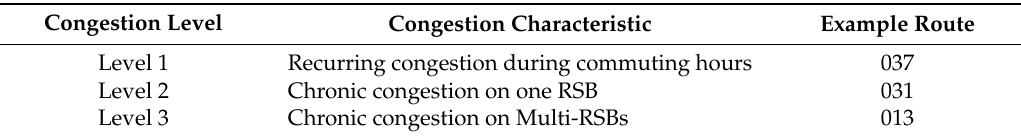
Table 8. The congestion level of the